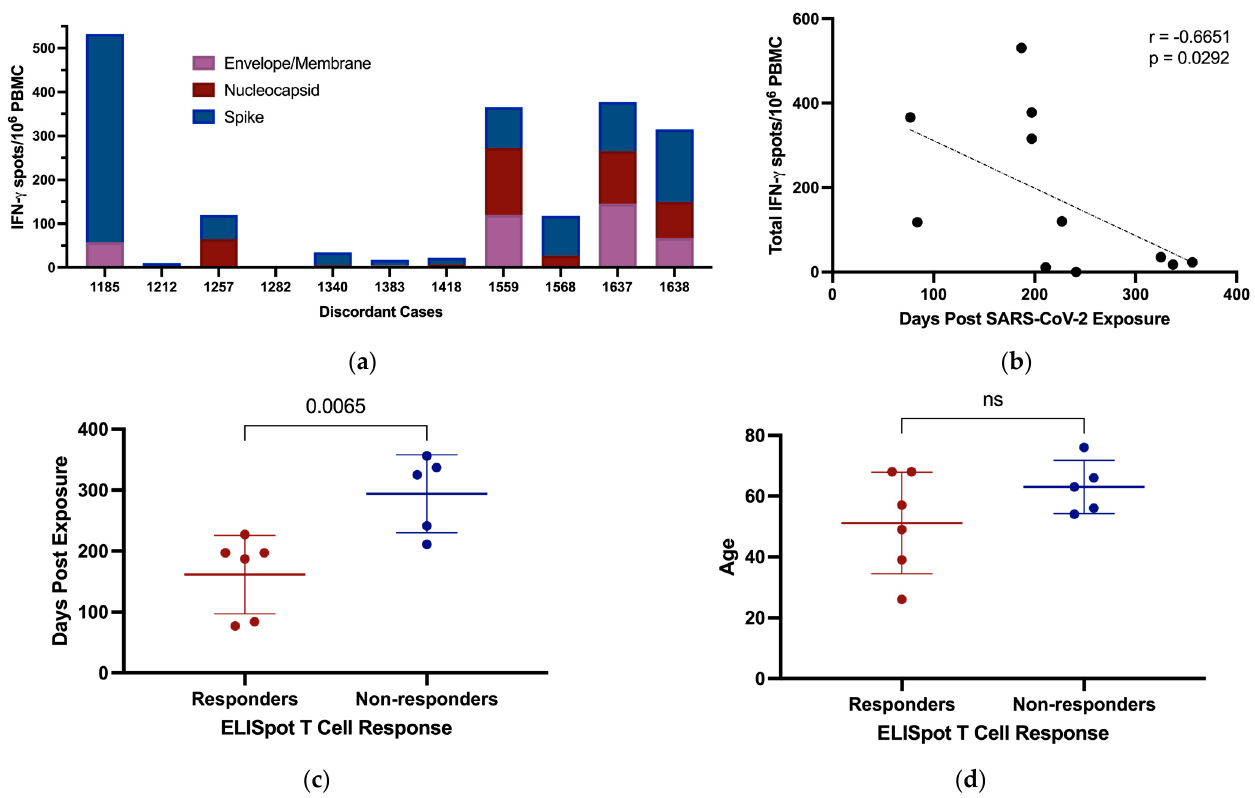
Figure 4. Production of IFN- γ by PBMC from discordant case subjects following stimulation with SARS-CoV-2 protein overlapping peptide pools. ( a ) IFN- γ producing T cells/10 6 PBMC of discordant case subjects following 24 h stimulation with SARS-CoV-2 E/M, N, and S protein peptide pools. ( b ) Scatterplot with line of best fit showing the relationship between total IFN- γ producing T cells de- tected by ELISpot following stimulation and the number of days post exposure. Spearman correla- tions were computed to assess the significance of correlations, with the correlation coefficient (r) and p value shown within the graph plot. ( c ) Days post exposure and ( d ) age were compared be- tween responders and non-responders on ELISpot. Red and blue shading of dots represents SARS- CoV-2 responders and non-responders respectively as defined by ELISPOT testing. The probability of a significant difference between groups was calculated using the Mann–Whitney test, with p val- ues and ns (not significant) shown above lines spanning the groups compared. To discriminate CD4 + and CD8 + T cell responses against SARS-CoV-2 in these indi- viduals, the PBMC of responders from the same sample time point used for ELISpot as- says were stimulated with SARS-CoV-2 peptide pools for 7 days’ in vitro and then ana- lyzed for IFN- γ production following 5 h restimulation (Figure 5a–f). Of the 6 responders by ELISpot, 4 had both CD4 + and CD8 + T cell responses to the SARS-CoV-2 peptide pools following in vitro restimulation (Figure 5g,h). Notably, subject 1185 had 4.8% of their CD8 + T cell population responding against S and subject 1638 had 8.7% of their CD8 + T cell pop- ulation responding against the E/M peptide pool combination. There were 4 individuals in our discordant cohort who had robust SARS-CoV-2-specific T cell responses between 2 and 6 months following exposure despite testing PCR negative, remaining seronegative, and having no overt symptoms of infection. This may indicate that these individuals ex- perienced viral replication but cleared all viral progeny before seroconversion through either rapidly developing immunity or pre-existing cross-reactive immunity.